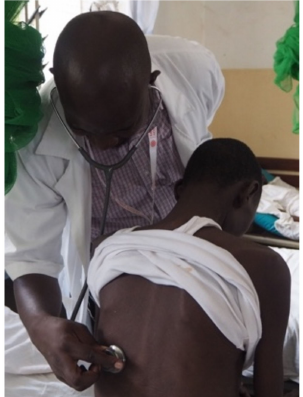
Figure 4. Clinical evaluation of a patient in the wards.